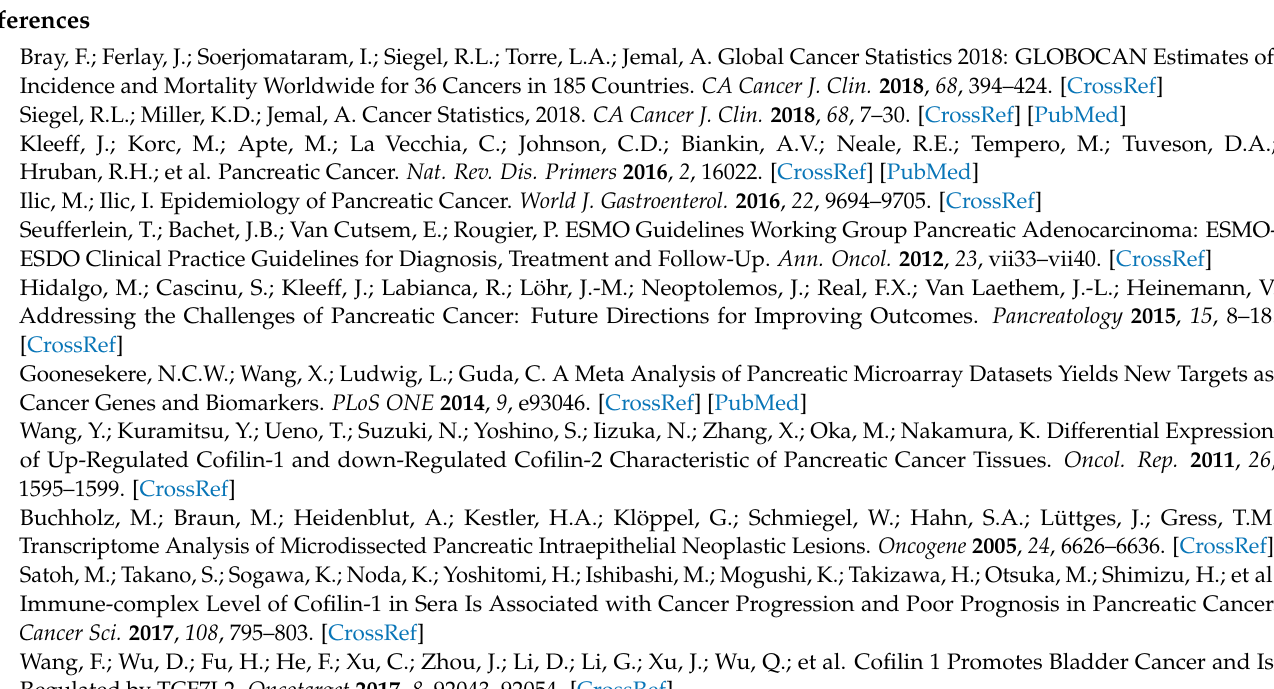
Figure S4: Uncropped Western blot images of doxycycline induced CFL1 Expression in nude mice, Figure S5: Uncropped Western blot images of apoptosis markers, Figure S6: CFL1 silencing inhibits migration, Figure S7: Uncropped Western blot images of cytosolic and nuclear protein distribution, Figure S8: In-silico STAT3 knockout in pancreatic cancer cells, Figure S9: Uncropped Western blot images of model-suggested cell cycle regulation, Figure S10: In-silico screening for therapeutic targets, Table S1: Model-based suggestions to induce apoptosis in pancreatic cancer